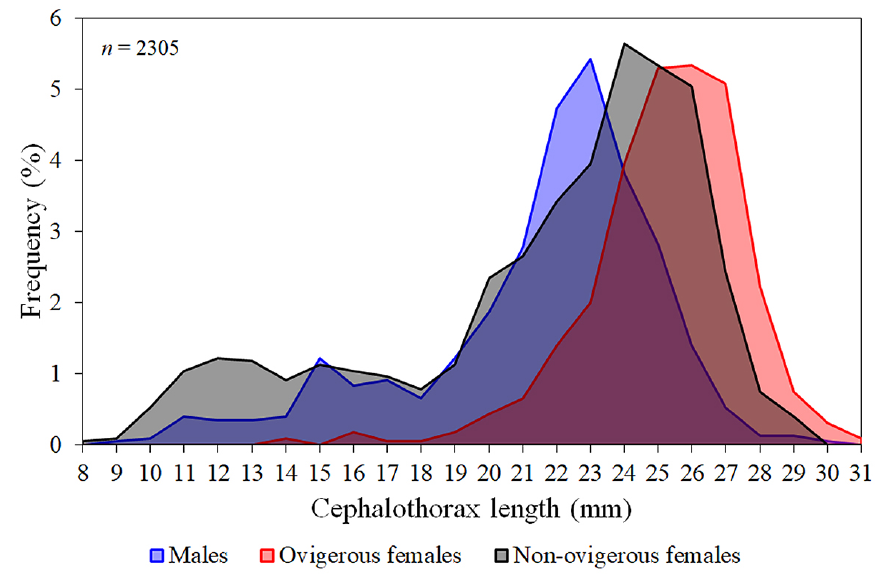
Figure 3. Size frequency distribution of males, non-ovigerous and ovigerous females Plesionika edwardsii in the Azorean region during the period 1999-2000.